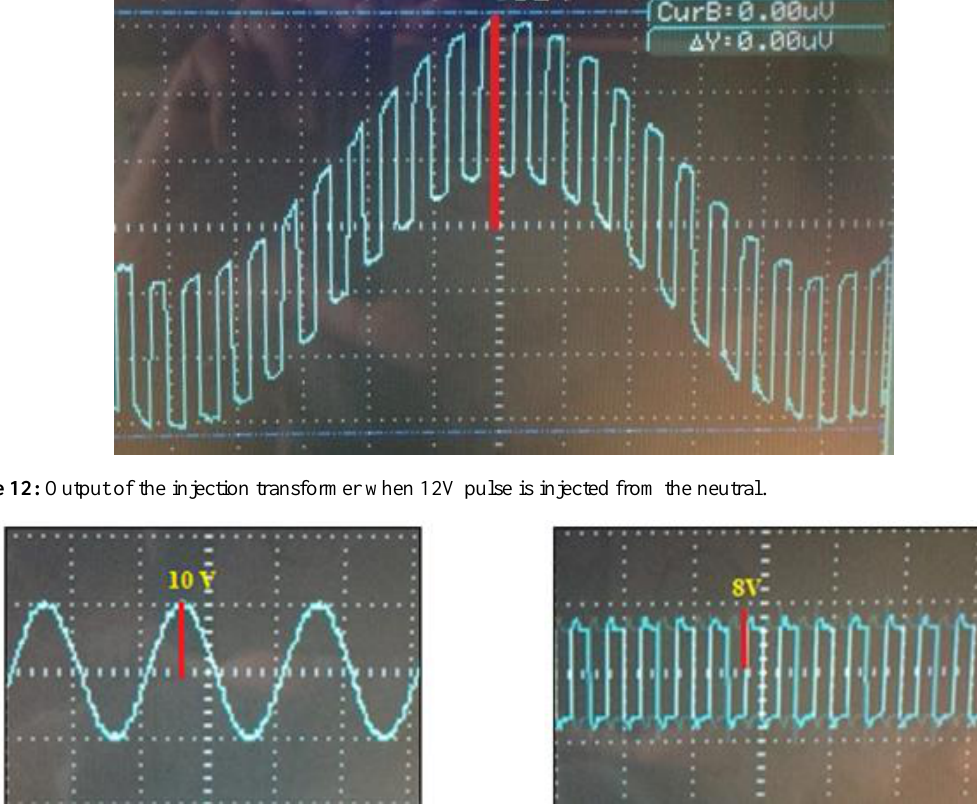
(a) (b) Figure 13 : Outputs of separation transformer. (a) AC voltage from the secondary. (b) Pulse voltage from the